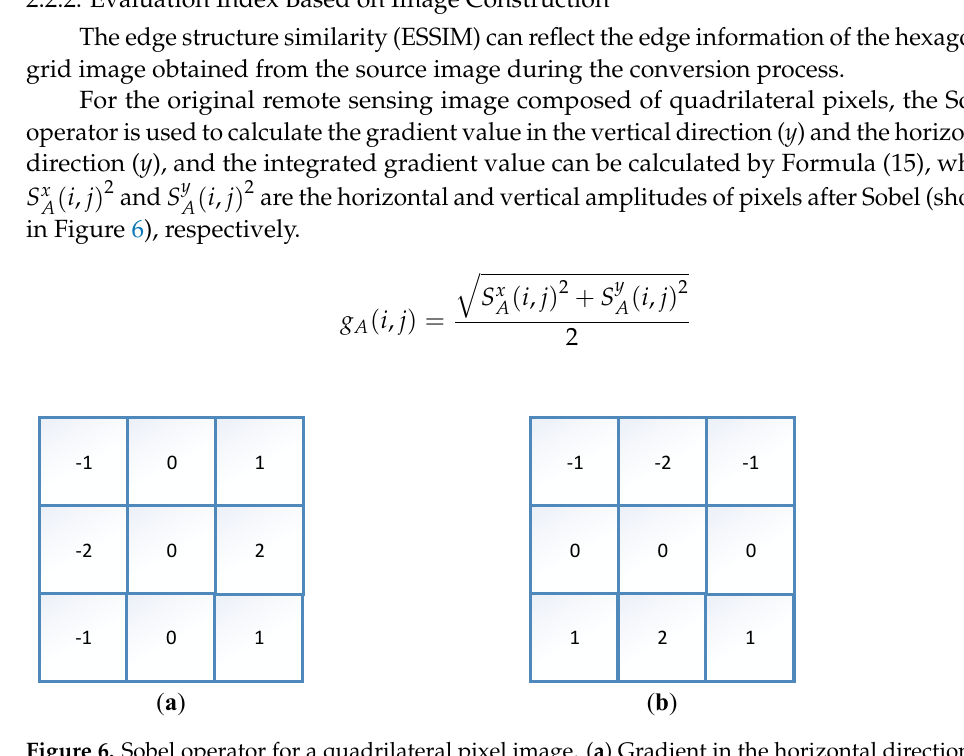
Figure 6. Sobel operator for a quadrilateral pixel image. ( a ) Gradient in the horizontal direction ( x ); ( b ) gradient in the vertical direction ( y ).